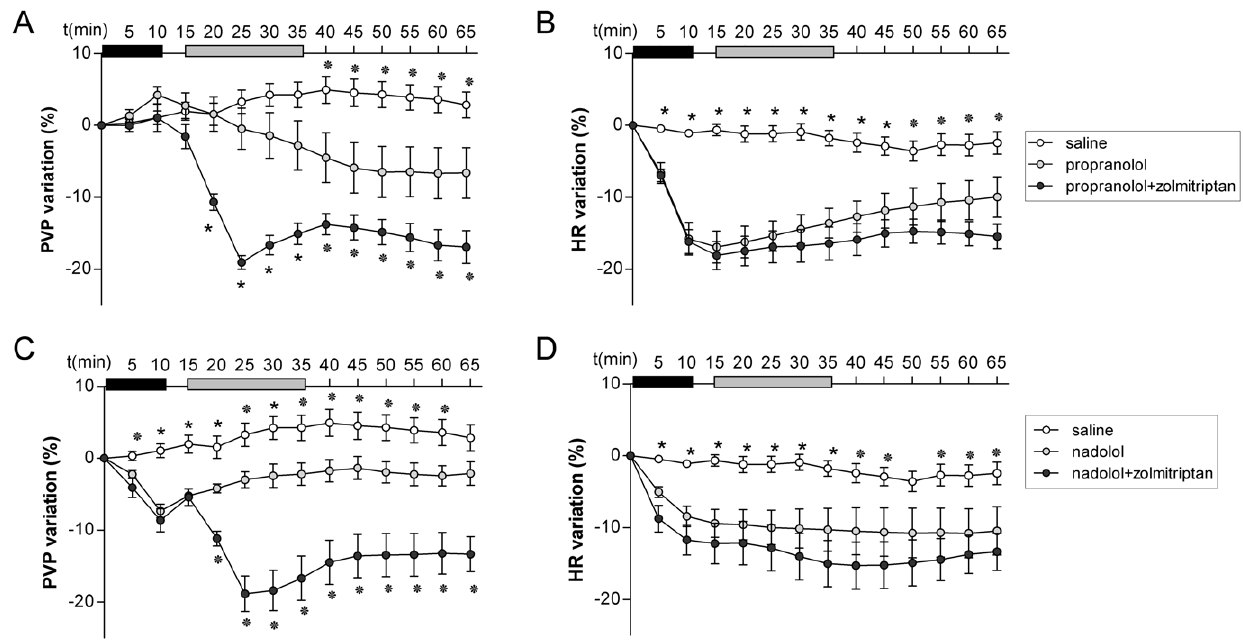
Figure 4. Effect of zolmitriptan in combination NSBB in CCl4-treated rats. Propranolol or nadolol were administered as an intravenous infusion and 5 minutes later, zolmitriptan or saline infusion were started and portal pressure (PVP) (A,C) and heart rate (HR) (B,D) recorded. Infusion time is indicated with black (beta-blockers) and grey bars (zolmitriptan). */* indicates significance vs rats receiving only NSBB (p , 0.05/0.01).